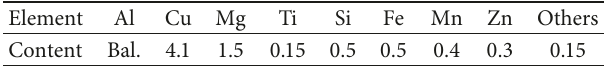
Table 2: Chemical composition of the 2A12Al powder